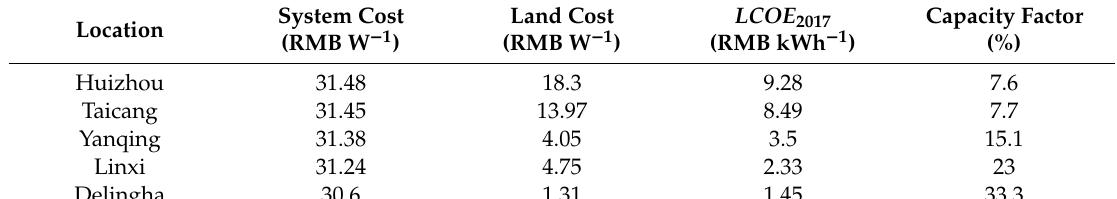
Table 5. Initial costs and LCOE present values for different locations in China.